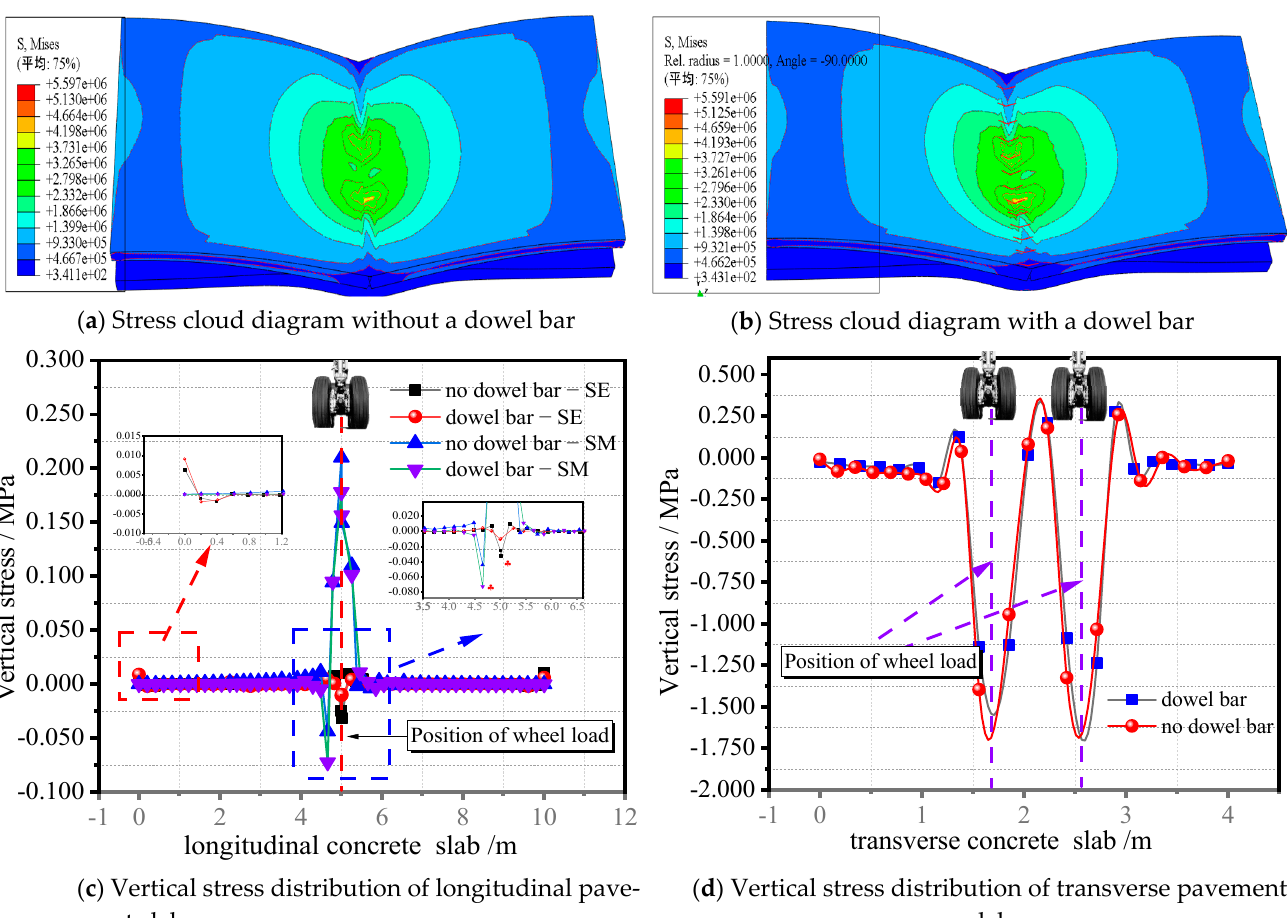
( d ) Vertical stress distribution of transverse pavement slab Figure 10. Stress distribution of the aircraft’s wheel load on the joints of adjacent pavement slabs.